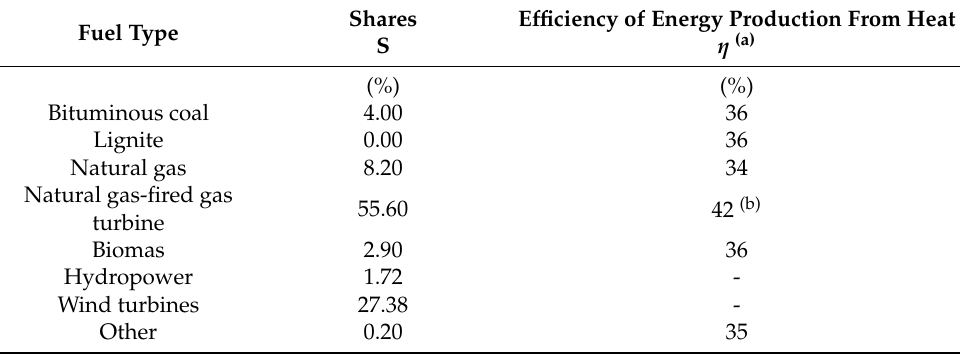
Table 9. The energy mix assumed in the third